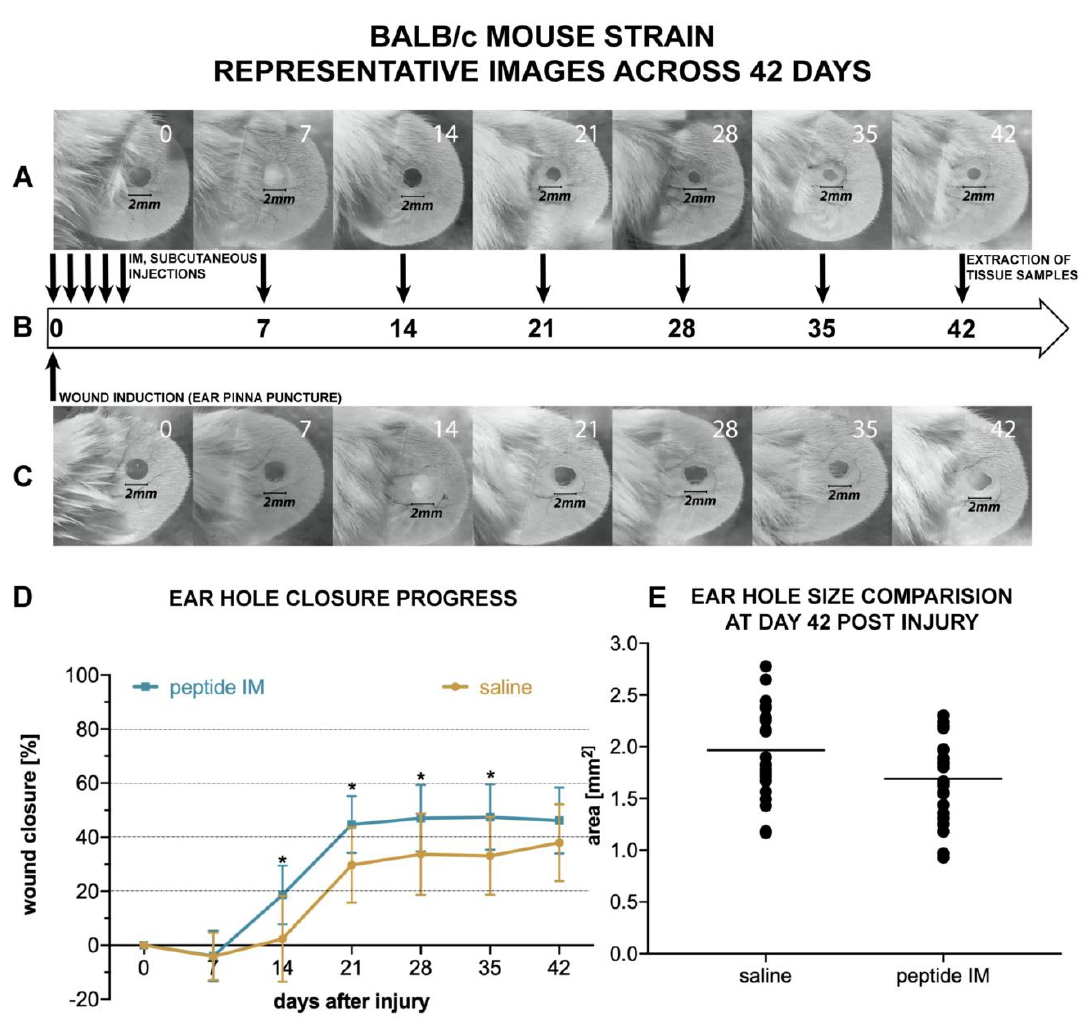
Figure 6. E ff ect of subcutaneous IM injections on ear punch closure in mice of the BALB / c strain. ( A , C ) representative photographs depicting the progress of ear hole closure in BALB / c mice, without or with IM stimulation. ( A ) the treatment group (IM injections; n = 12 mice) and ( C ) shows the control group (saline injections; n = 12 mice). ( B ) the timeline of experiments and injection intervals. ( D ) the mean area of BALB / c mice ear holes throughout the experiment; n = 6; error bars represent SD; and statistical significance * means p ≤ 0.05. ( E ) the distribution of ear hole area at 42 days post injury in the BALB / c mice strain, where each dot represents one ear hole and the black line represents the mean value.